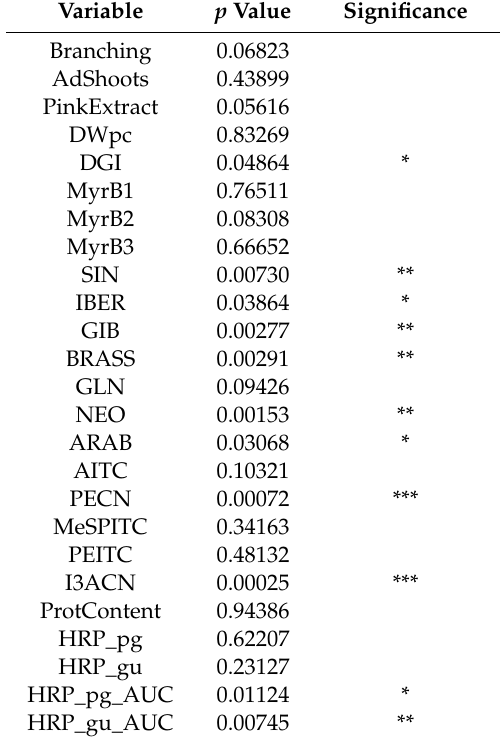
Table 2. Statistical di ff erence between the two horseradish hairy root clone groups distributed based on the inoculated organ (petiole or leaf blade), for the di ff erent examined features (variables). Variable p Value